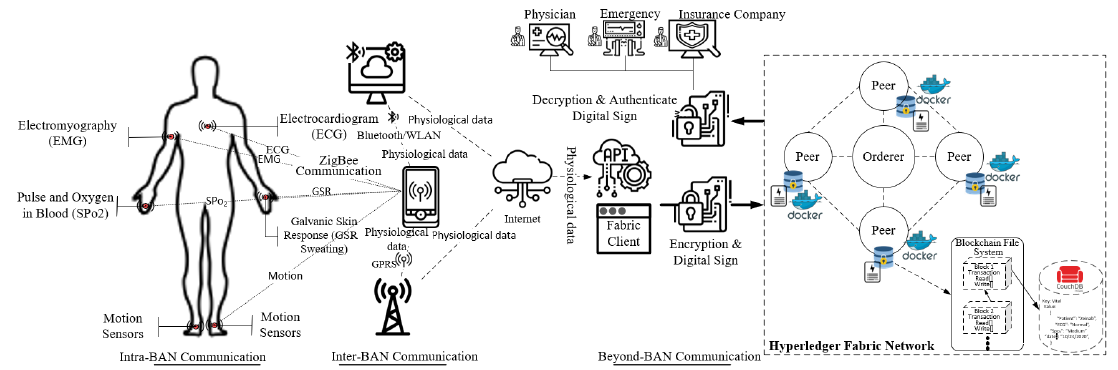
Figure 2. Blockchain-enabled WBAN